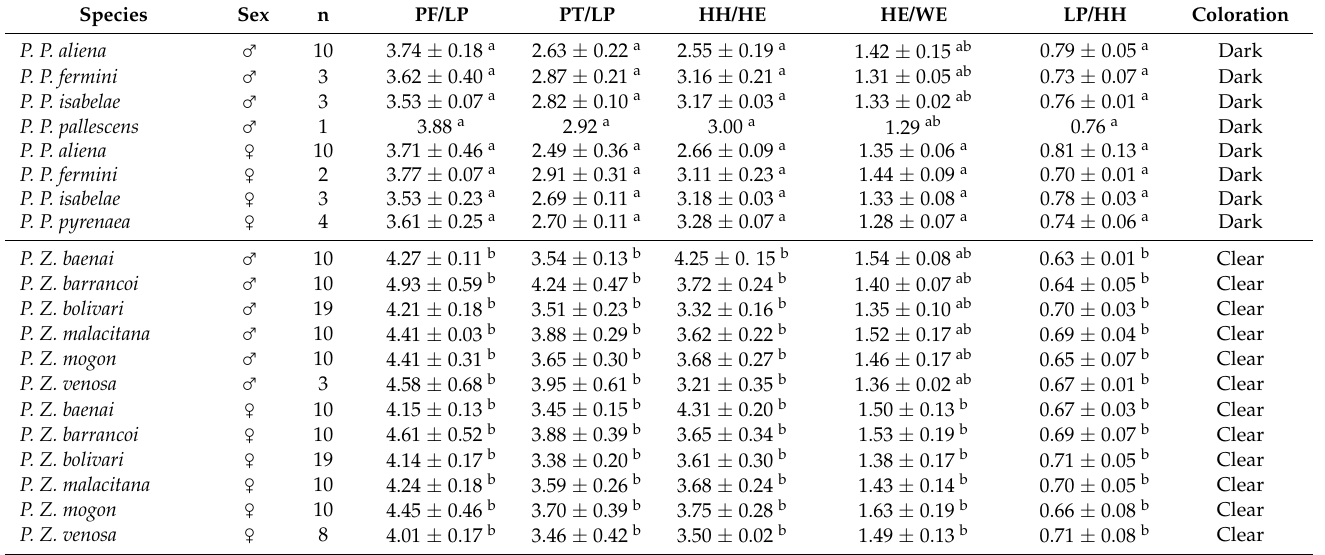
Table 4. Degree of troglomorphism in the genus Petaloptila. The values of PF/LP, TP/LP, HH/HE, HE/WE, and LP/HH are mean ± S.D. PF/LP and TP/LP are ratios used to assess appendage elongation (PF, hind femur length; PL, pronotum length; PT, hind tibia length); HH/HE and HE/WE to assess ocular size reduction (HH, head height; WE, eye width; EH, eye height); LP/HH to assess cephalic elongation. The differences in the structures on Zapetaloptila and Petaloptila were determined using Kruskal-Wallis test. Mean values with different superscripts within the same column and for the same parameter indicate statistically significant differences ( p -value ≤